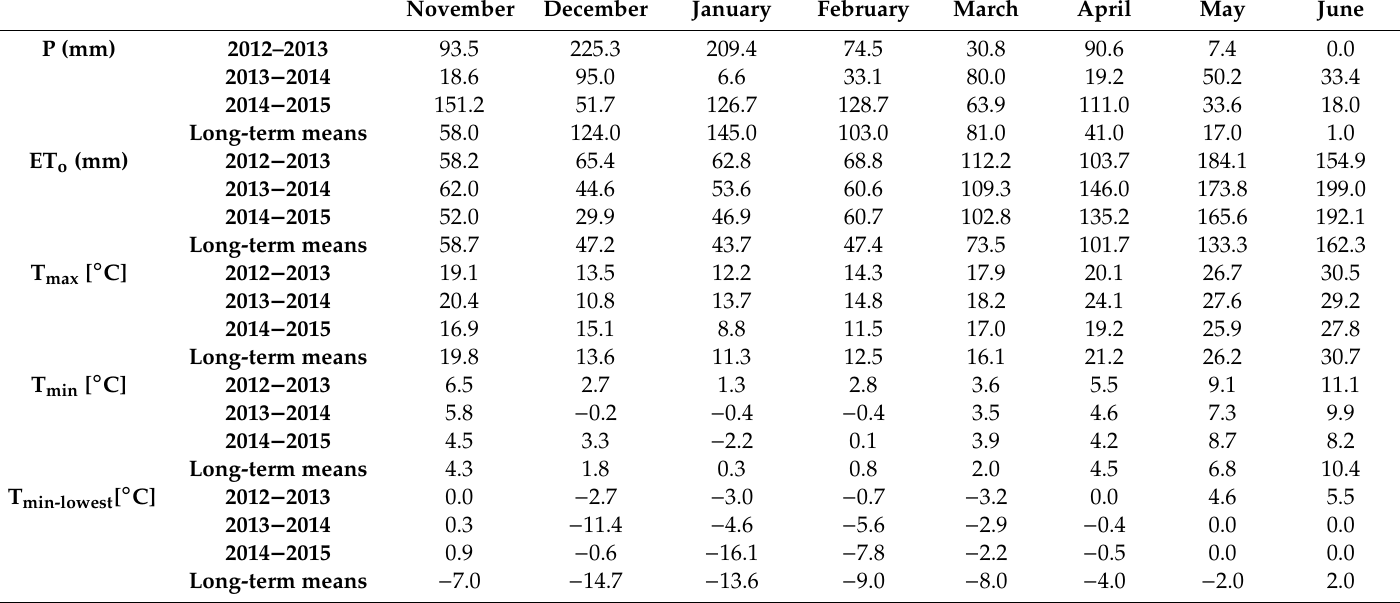
Table 3. Weather parameters during the three growing seasons, compared to long-term